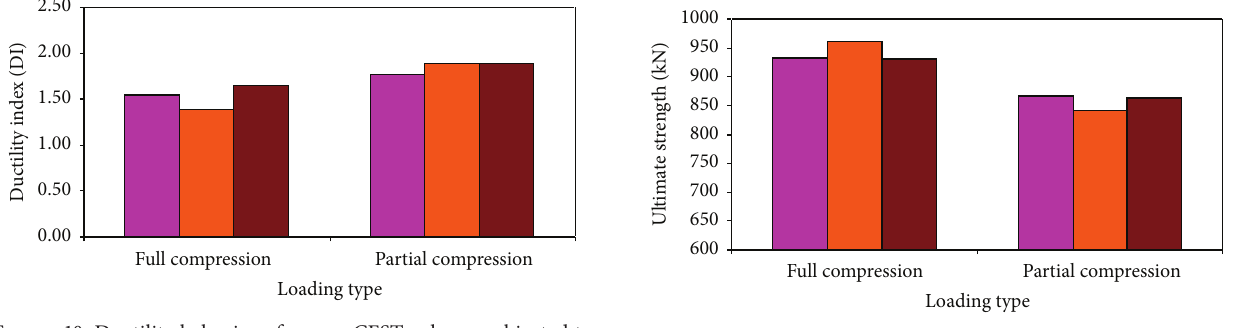
Figure 12: Ultimate strength of square CFST column subjected to full and partial